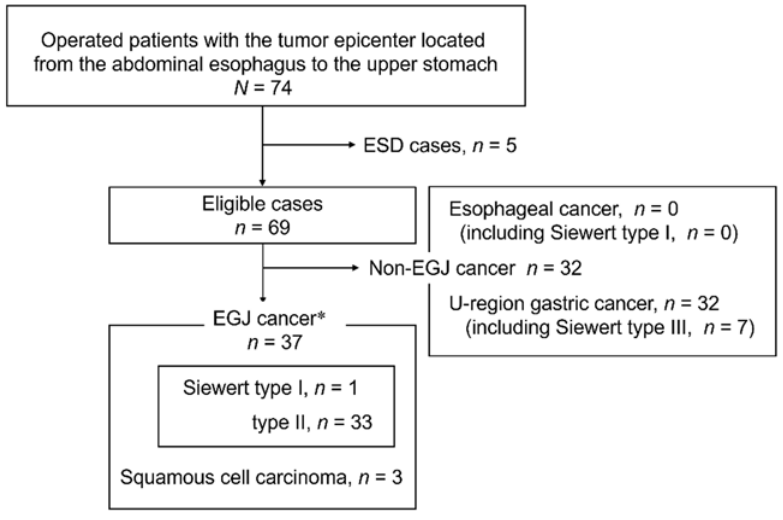
Figure 3. Flow chart of this study. * According to Nishi’s classification. ESD—endoscopic submucosal resection; EGJ—esophagogastric junction.